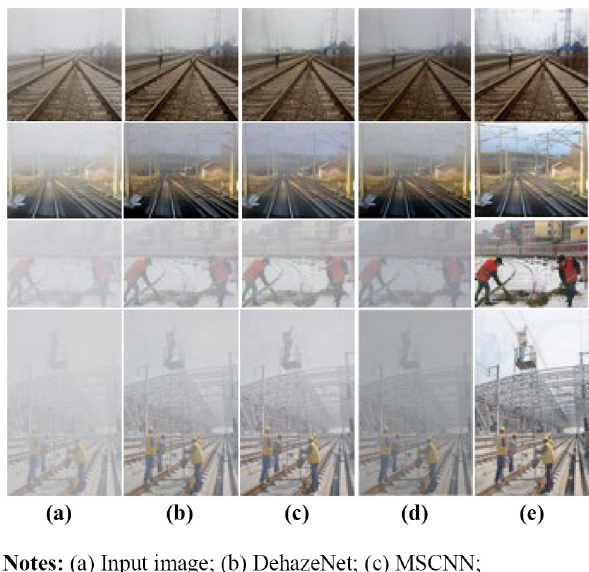
Figure 8. Dehazing results evaluated on railway hazy images